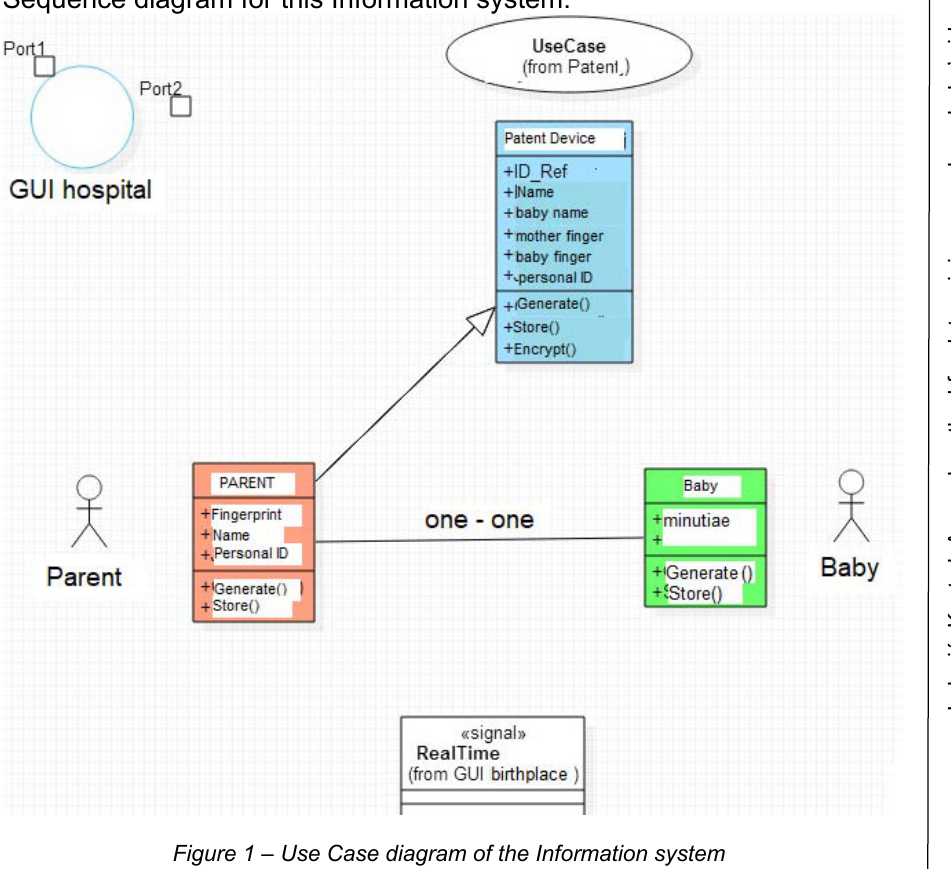
Figure 1 – Use Case diagram of the Information